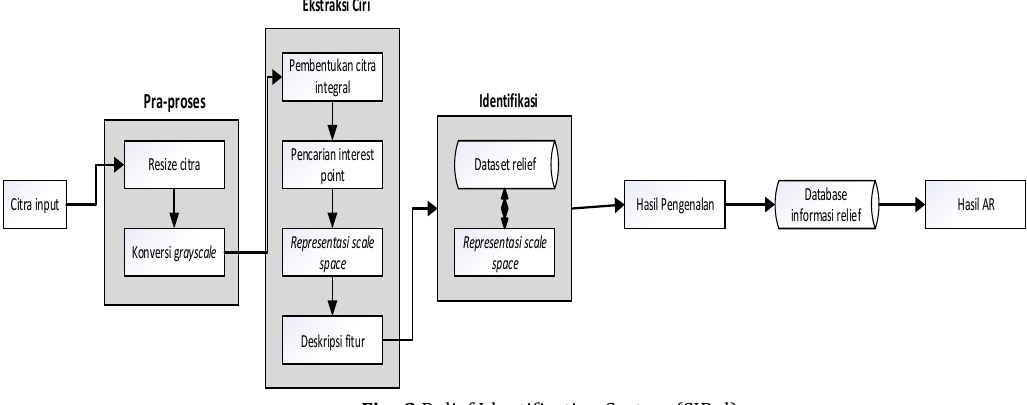
Fig. 2 Relief Identification System